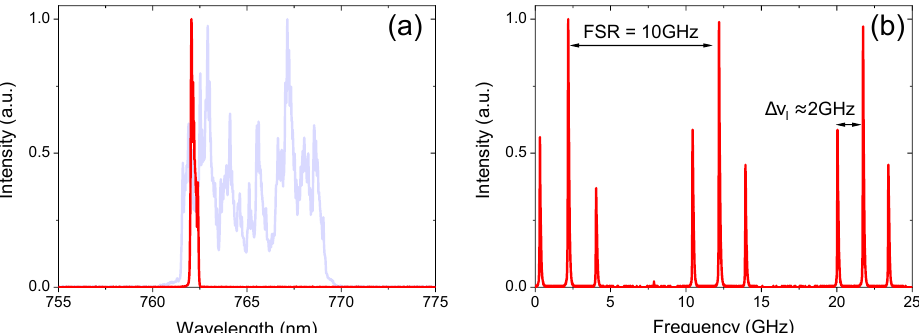
Figure 6. ( a ) Laser spectrum with (red) and without (blue) VBG. ( b ) Scanning Fabry–Perot interfer- ometer demonstrating three longitudinal modes.